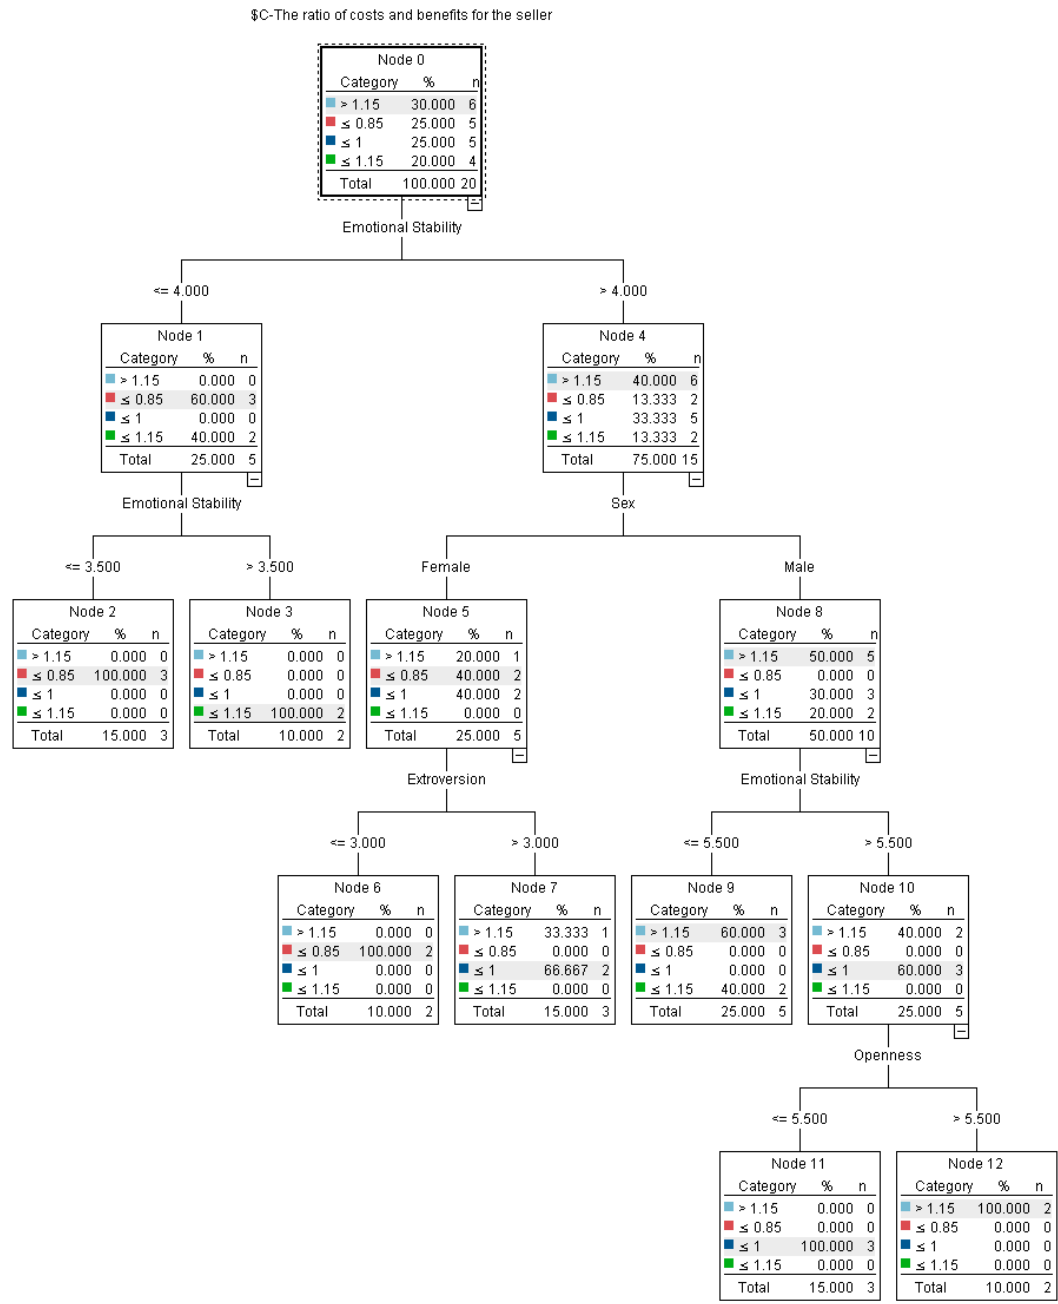
Figure A1. Decision tree for seller.